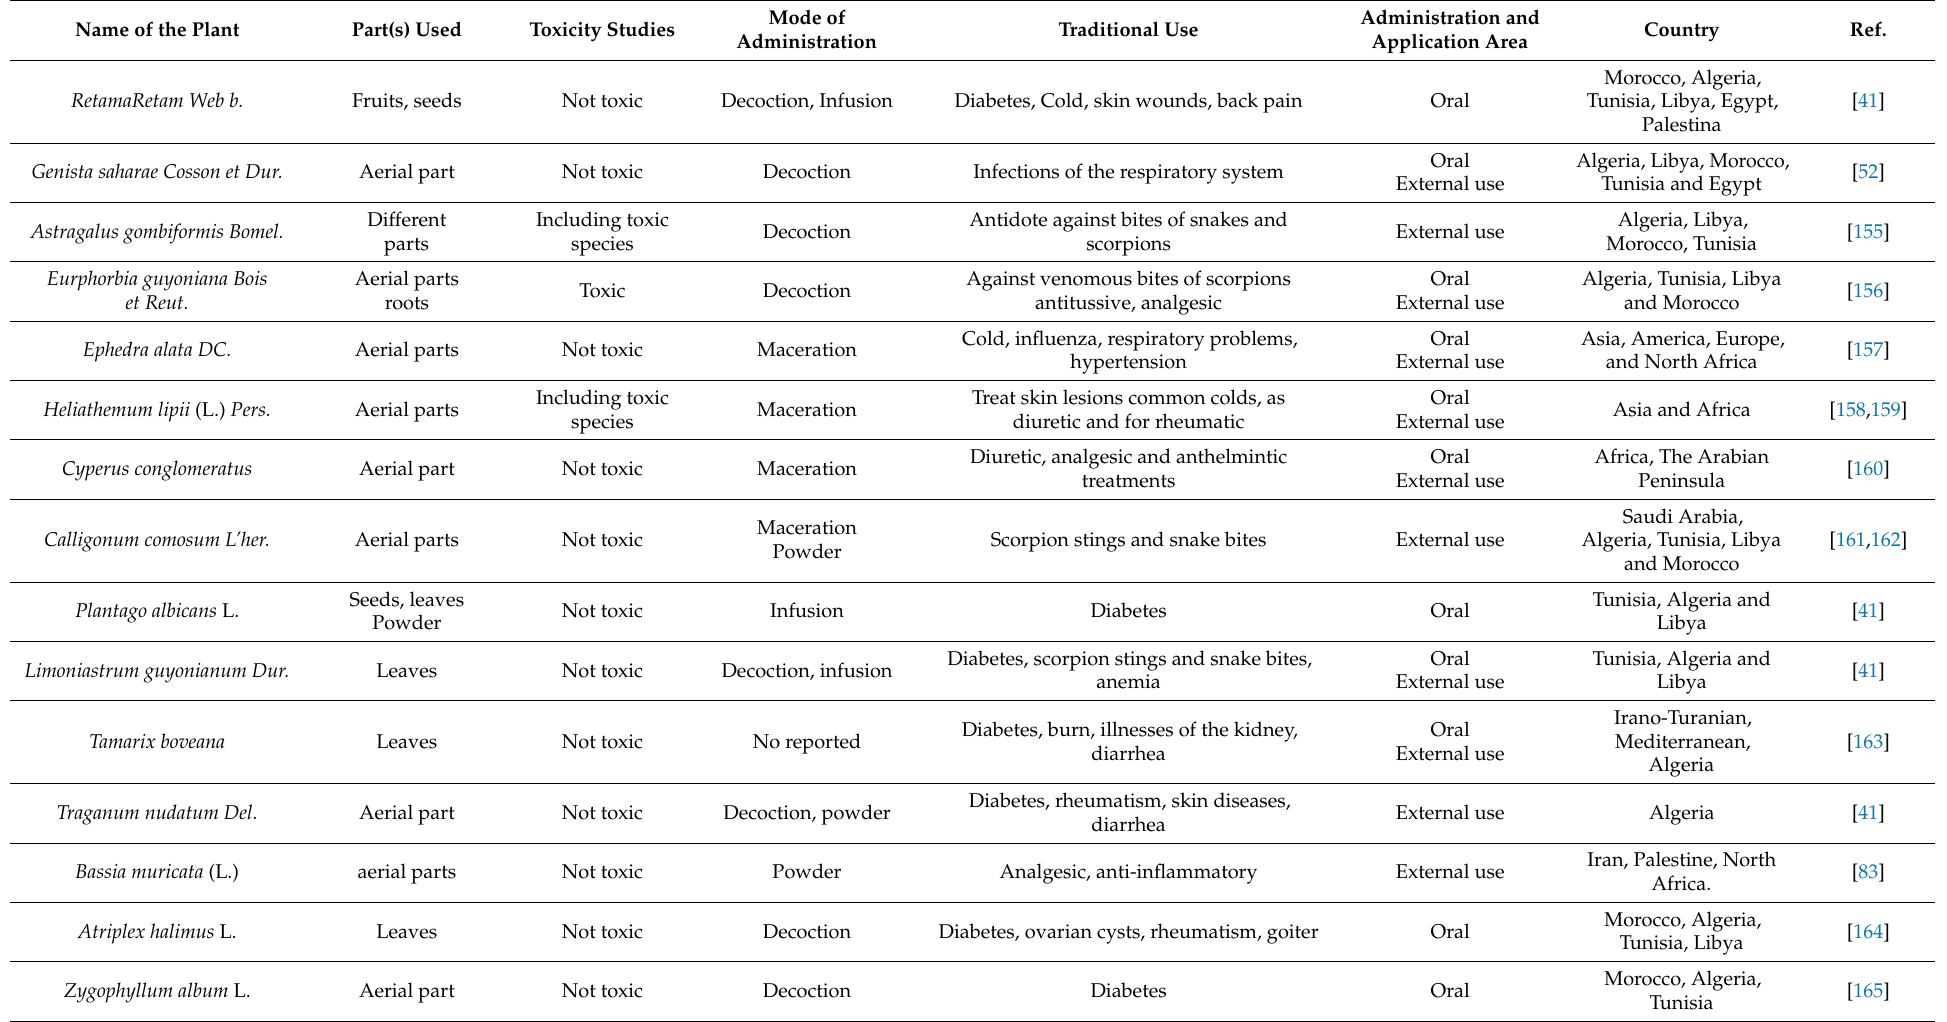
Table 1. Medicinal plant used in Saharan regions, their habits, parts used, mode of administration, countries where they are used, toxicity, and